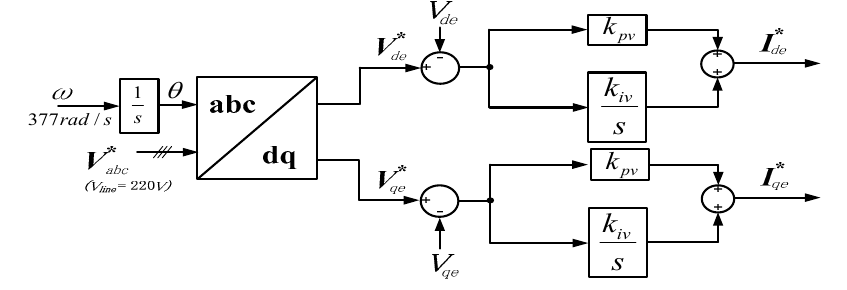
Figure 3. Voltage control block diagram.